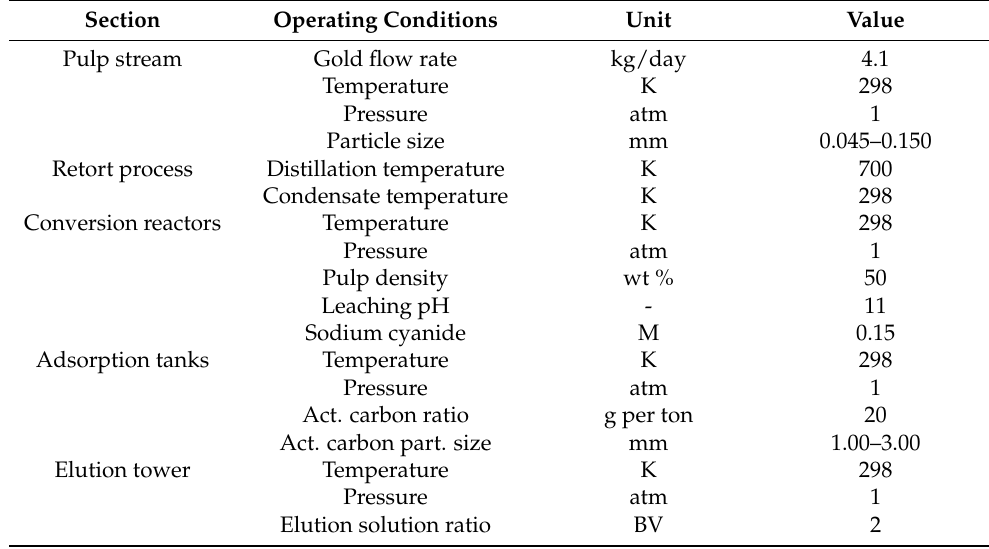
Table 3. Hydrometallurgical process simulation conditions when the leaching agent is sodium cyanide. Section